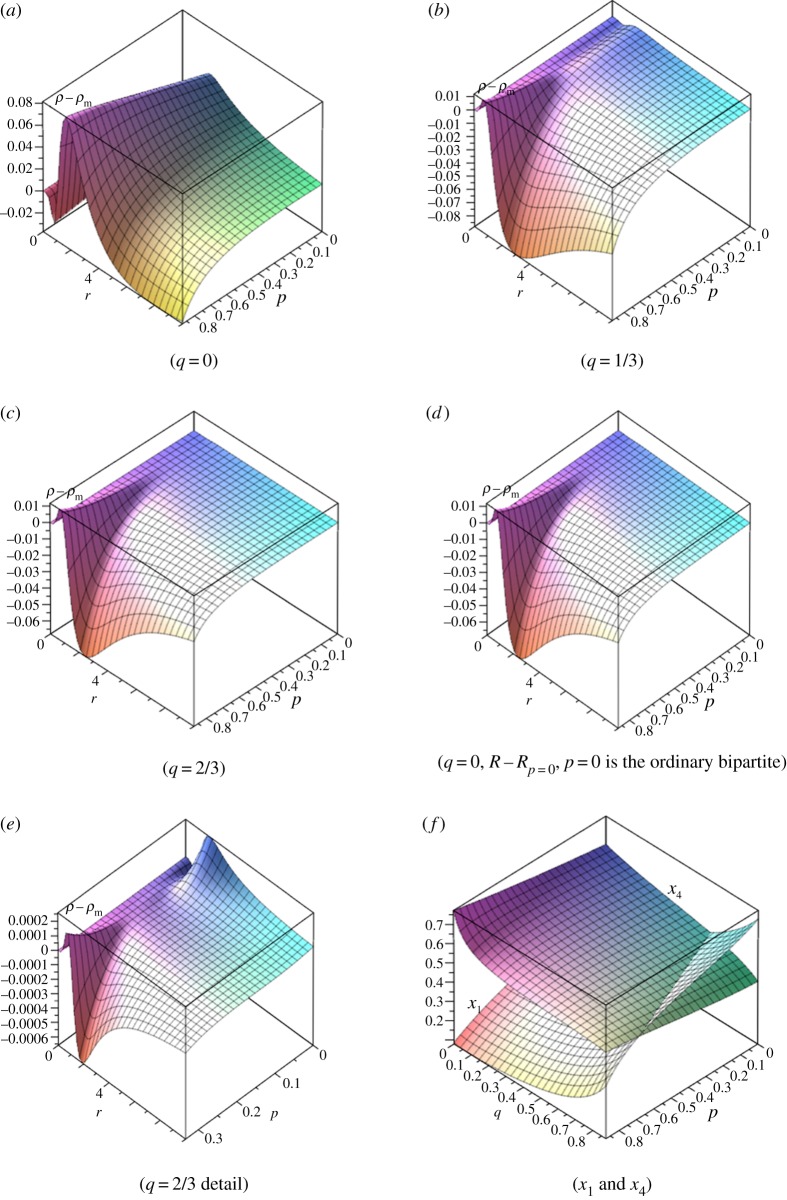
Fixation probabilities minus Moran probabilities for (2, 5) partial bipartite graph for varying q values (a–d), (e) detail of (c) (0≤p≤1/3) and (f) the x1 (vertex in V2 component) and x4 (vertex in V5 component) probabilities for r=2.